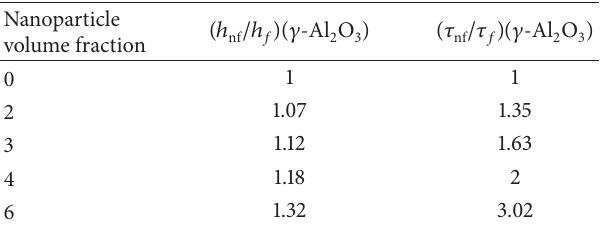
ticle volume fraction at Re = 20000. Table2:Averageheattransfercoefficientratioincomparisontowall shear stress